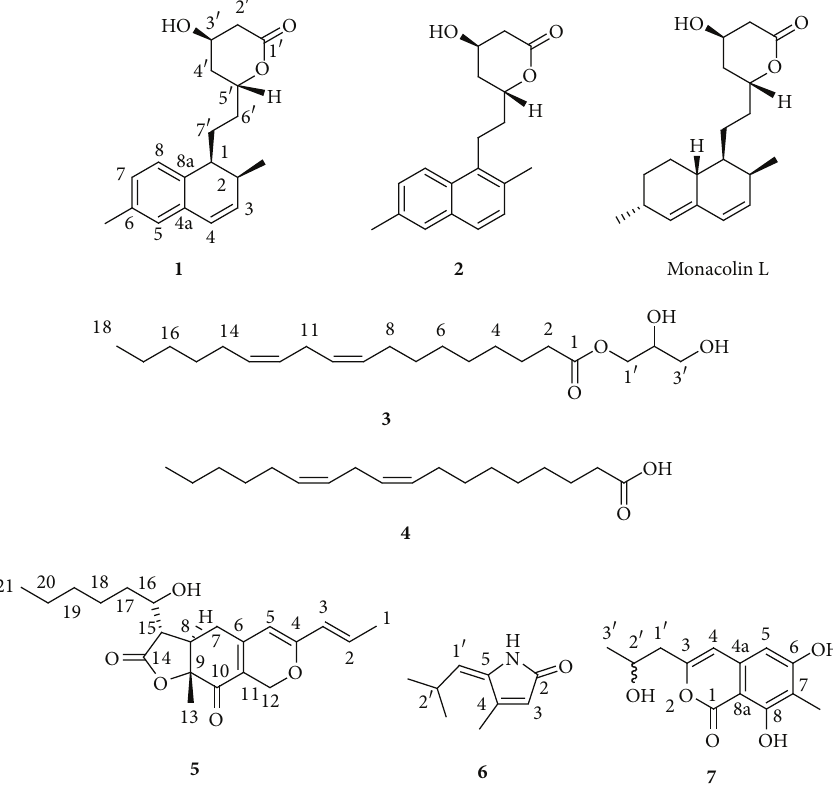
Figure 1: Structures of compounds 1 – 7 and monacolin